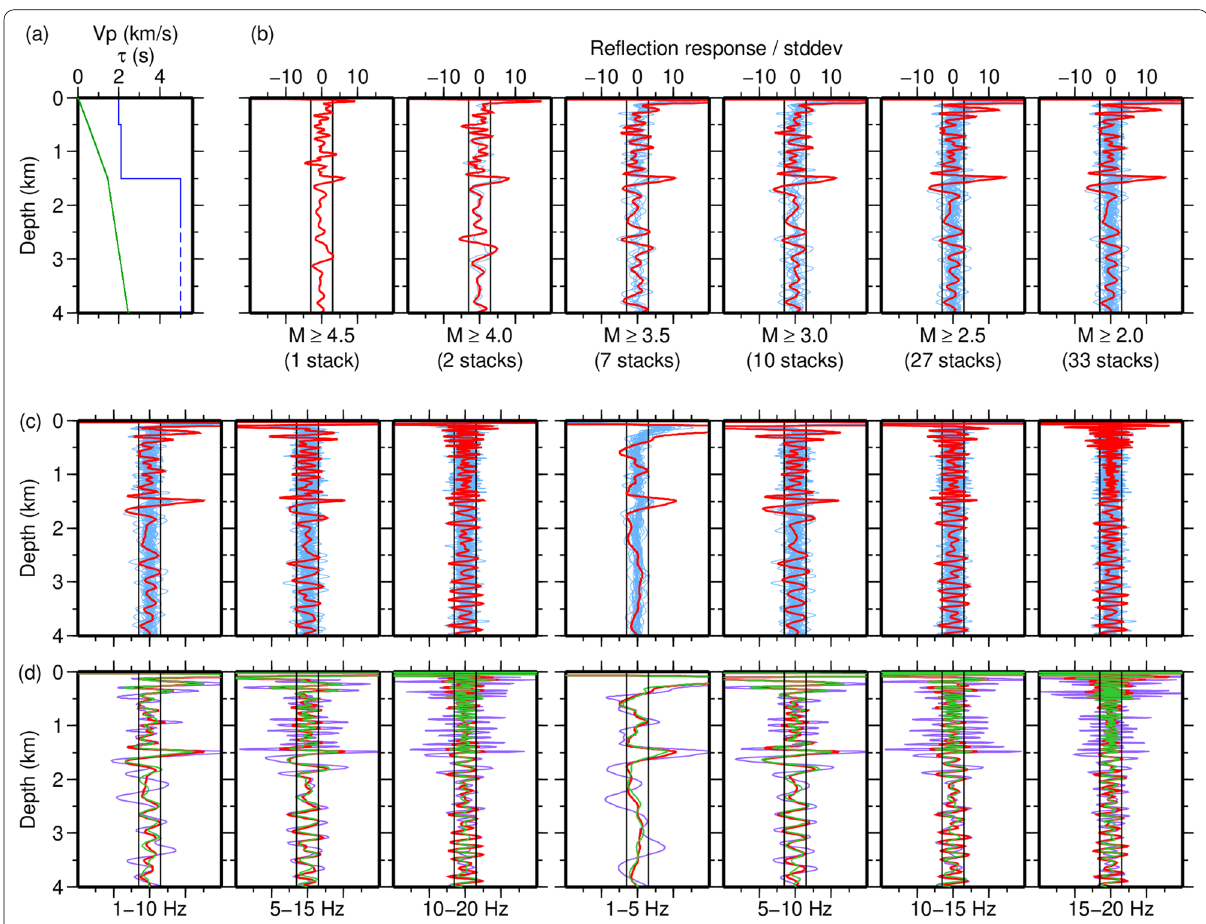
Fig. 3 Depth sections of the reflection responses at Station E.STHM. a Velocity profile (blue) and the relationship between lag time τ and depth (green) that were used to generate the depth sections. b Estimated reflection responses for different numbers of stacks based on magnitude thresholds. Blue lines indicate the ratios of averages to standard deviations of individual earthquakes ( a ave i (τ)/σ a i (τ) ). Red lines show the ratios of averages to standard deviations of weighted stacks ( a ave (τ)/σ a (τ) ). Black lines indicate ± 3 . The frequency band is 1–10 Hz. c Reflection responses for various frequency bands estimated from all 33 earthquakes. d Reflection responses for various frequency bands estimated from all earthquakes deeper than 60 km (purple; 113 events), 80 km (red; 33 events), and 100 km (green; 20